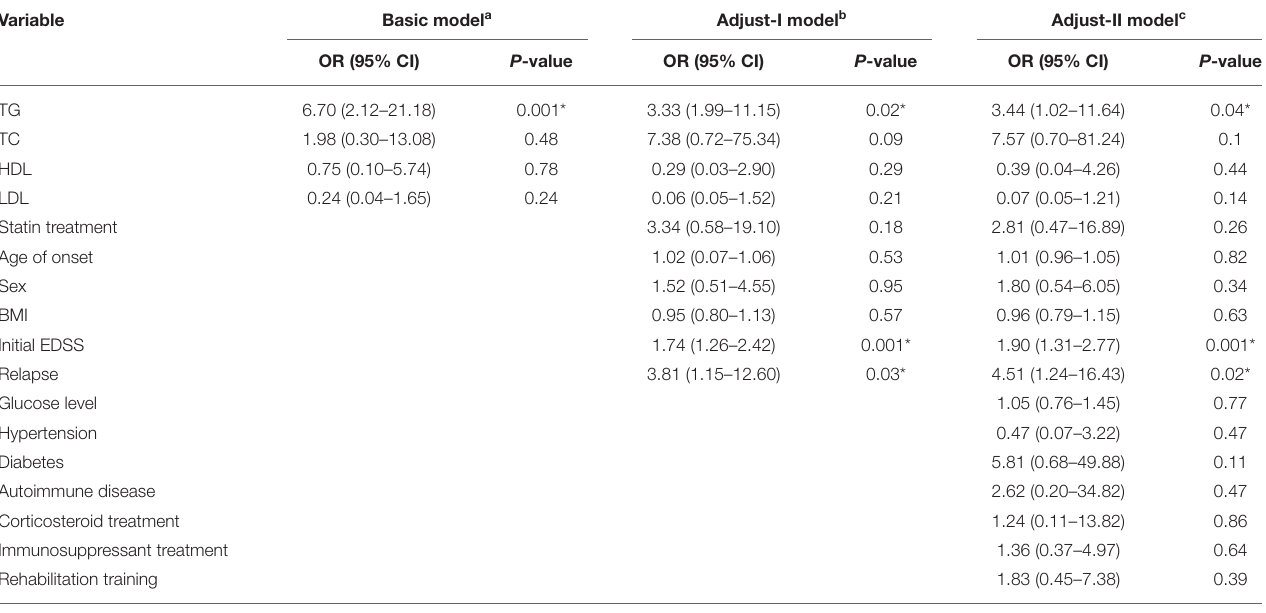
TABLE 4 | Adjusted logistic regression models of lipid parameters associated with the outcomes of NMOSD patients.